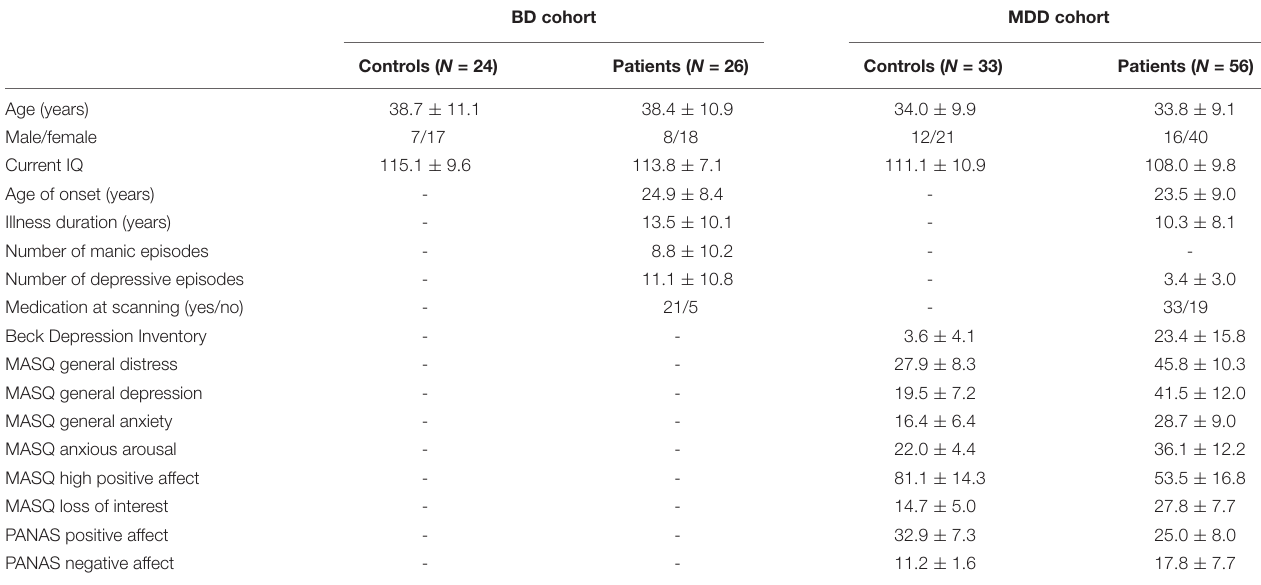
TABLE 1 | Sample characteristics of the study